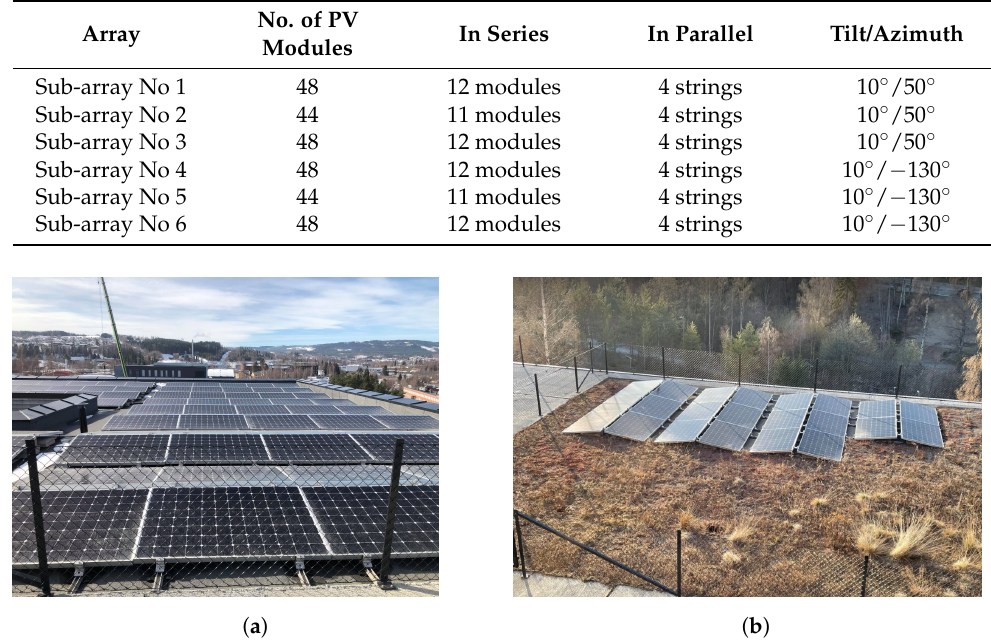
Figure 2. The Smaragd building PV system. ( a ) Fifth-floor PV system. ( b ) Second-floor PV